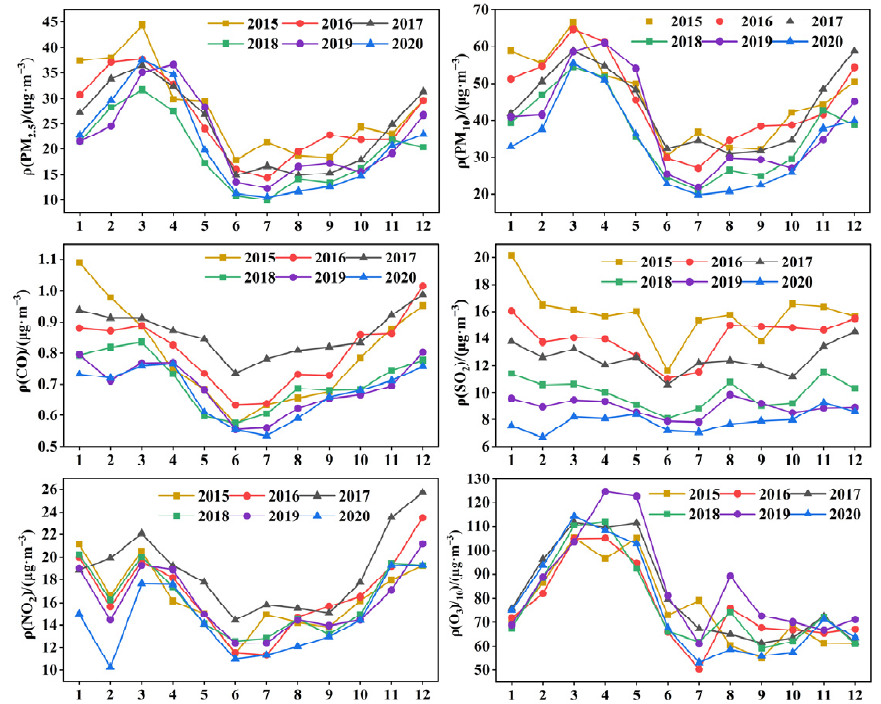
Figure 7. Monthly variation of air pollutant concentration in Yunnan from 2015 to 2020.